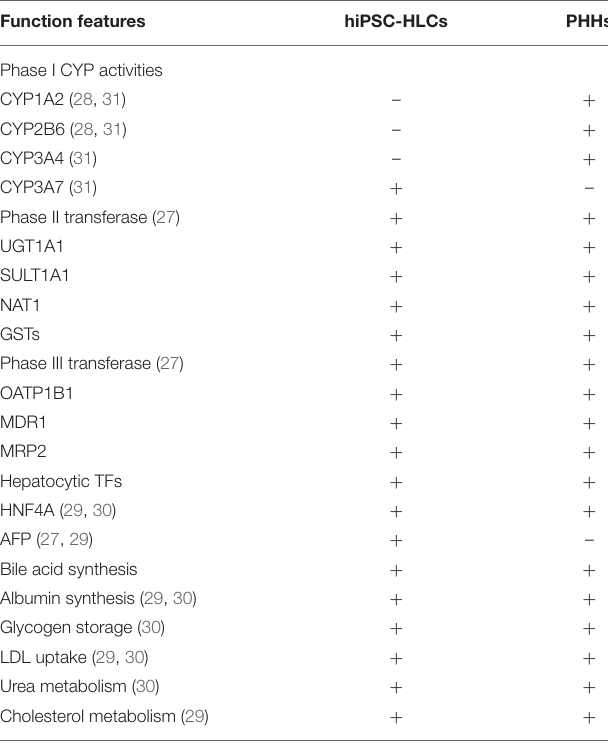
TABLE 1 | Functional features of hepatocyte-like cells (HLCs) derived from human induced pluripotent stem cells. Function